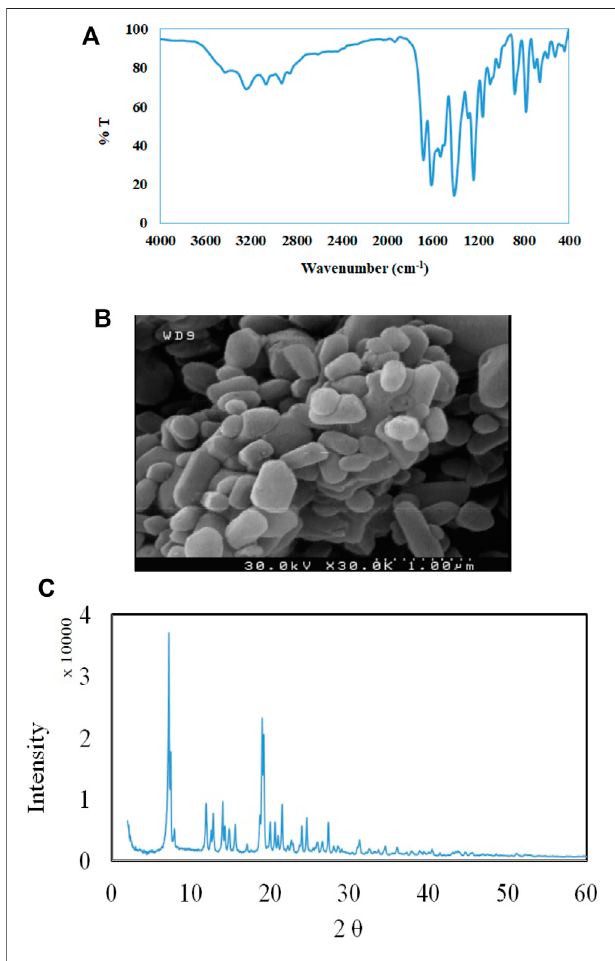
FIGURE 1 | (A) FT-IR spectra, and (B) SEM image of TMU-24 (C). XRD patterns of TMU-24.